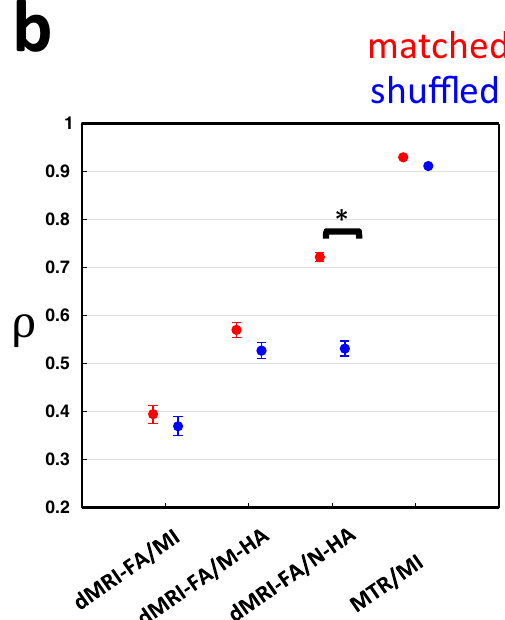
Fig. 5 | Average laminar pro fi les of FA, Nissl-HA, and myelin-HA across all parcels and the results of a spatial randomization condition to test the regional speci fi city of parcel-wise histology to MRI correlations. The results show Nissl-HA more closely matches the laminar pro fi le of dMRI-FA, and is more sensitive to shuf fl ing of horizontal MRI locations. a Normalized laminar pro fi les of dMRI-FA,Myelin-HA,andNissl-HAthroughthecorticalthickness,fromroughly100 μ m above the white/gray matter boundary (WGB) to roughly 100 μ m below the pial sur- face (PIA), computed from the average of all columnar parcels (see Methods, Fig. 3).